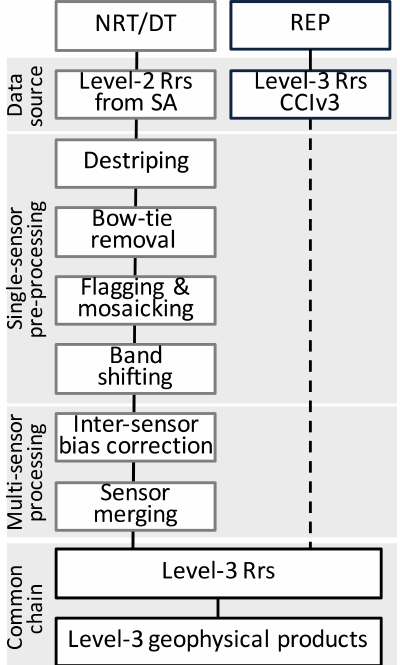
Figure 2. Flow chart of the processing chains for the two data pro- duction lines: NRT–DT and REP modes. SA stands for space agen- cies. The dashed vertical line indicates that the CNR REP process- ing mode only involves the application of the regional fine-tuned algorithms for the retrieval of the geophysical